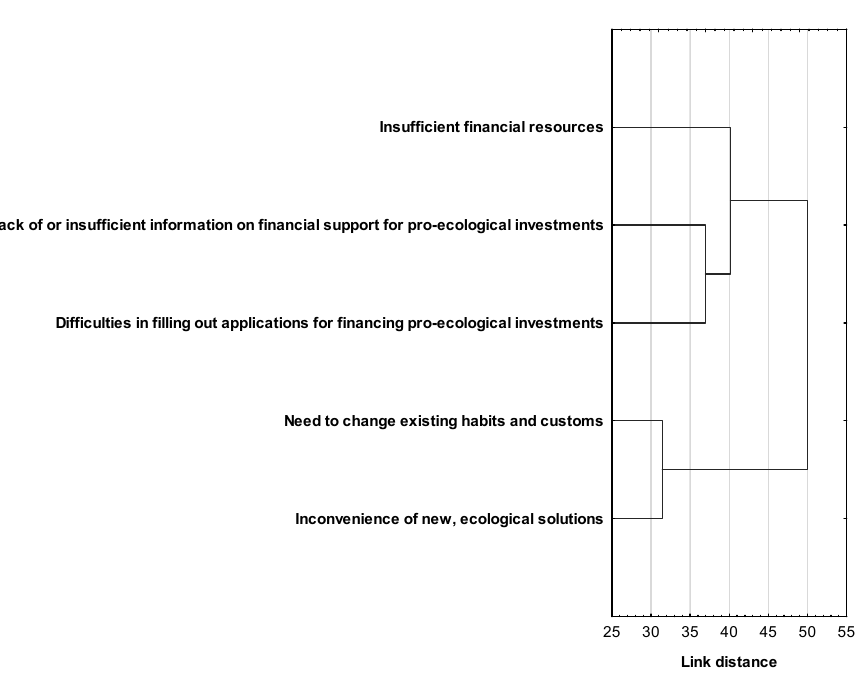
Figure 3. Dendrogram obtained for individual limiting factors in terms of the degree of limitation of the studied undertaking of pro ‐ ecological behaviors (results of cluster analysis using agglomera ‐ tion).